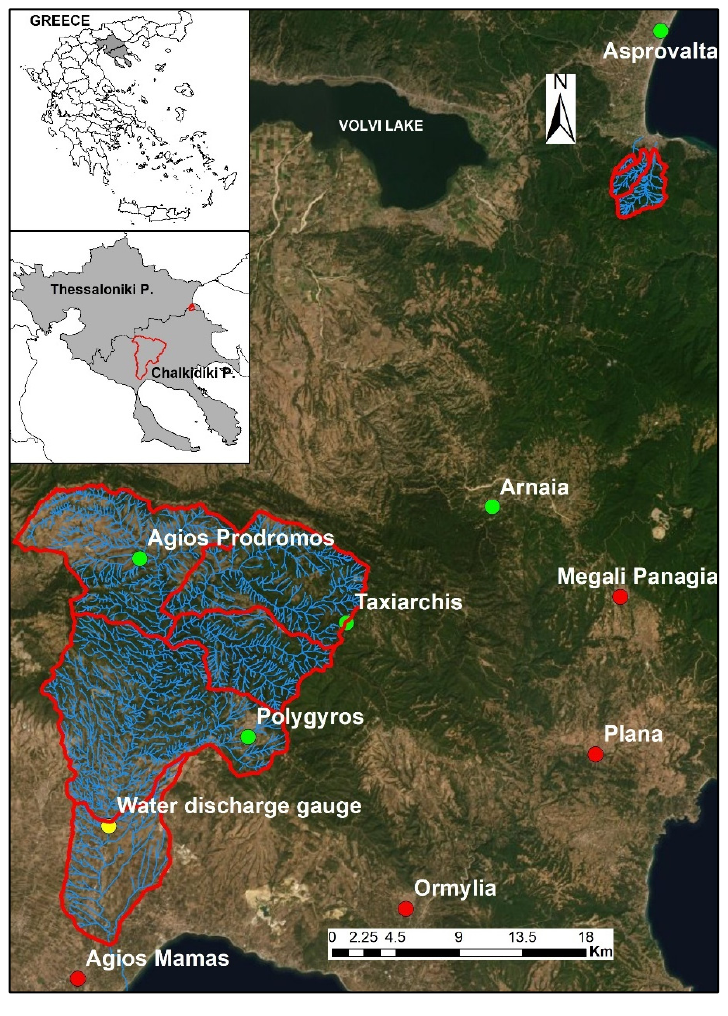
Figure 4. Location of the rainfall observatories used for the hydrologic modeling (the observatories marked in red are no longer in operation). Hydrology 2020 , 7 , x FOR PEER REVIEW